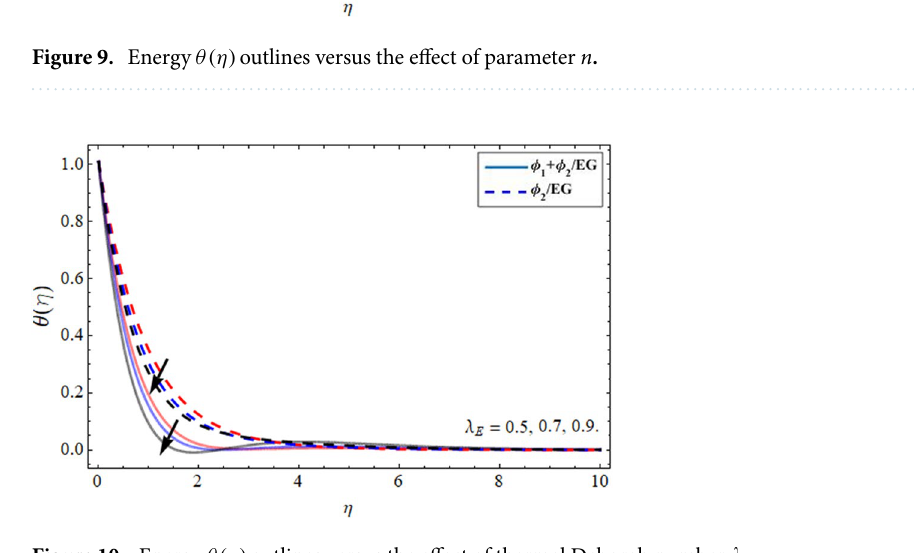
Figure 10. Energy θ(η) outlines versus the effect of thermal Deborah number (cid:31) E